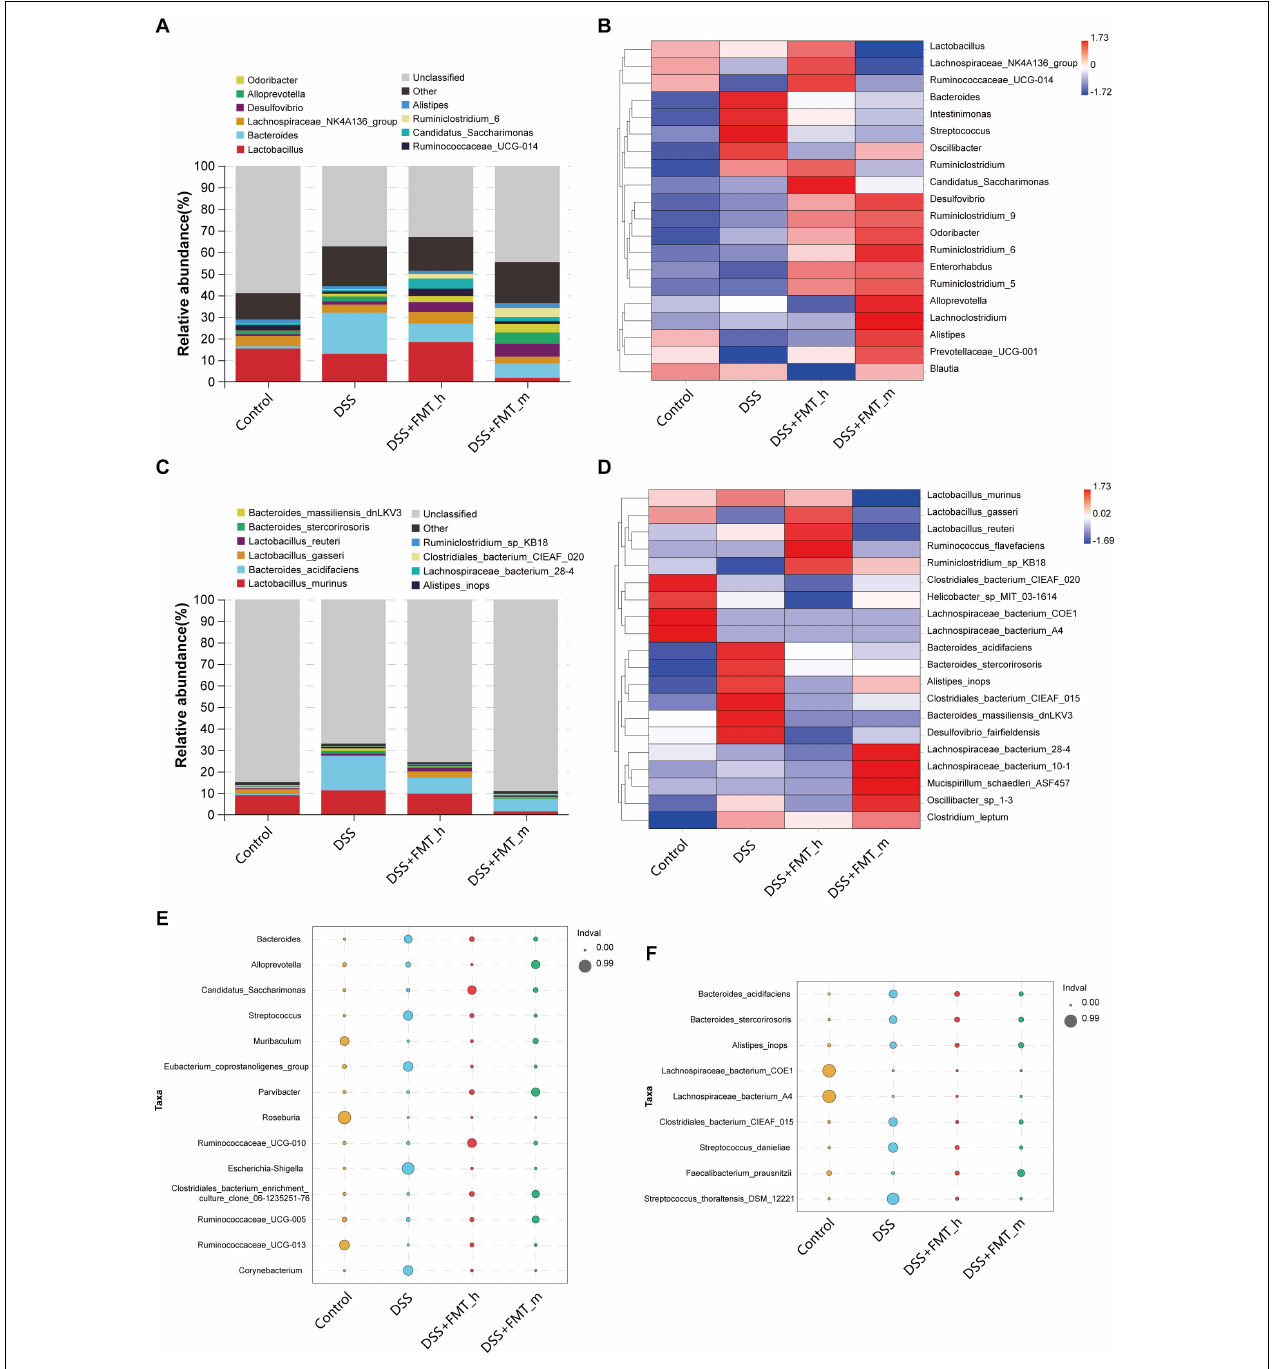
FIGURE 4 | FMT modulates the structure of the gut microbiota in colitis mice. (A) Stacked bar plot displays the genus structure of the gut microbiota in each group of mice. (B) Heatmap analysis of the difference in genera of the gut microbiota in each group of mice. (C) Stacked bar plot of species. (D) Heatmap analysis of species. (E,F) Bubble diagram analysis of indicators. The bubble size represents the indicator value (IndVal) of the species in the corresponding group, and the bubble color represents the grouping information.